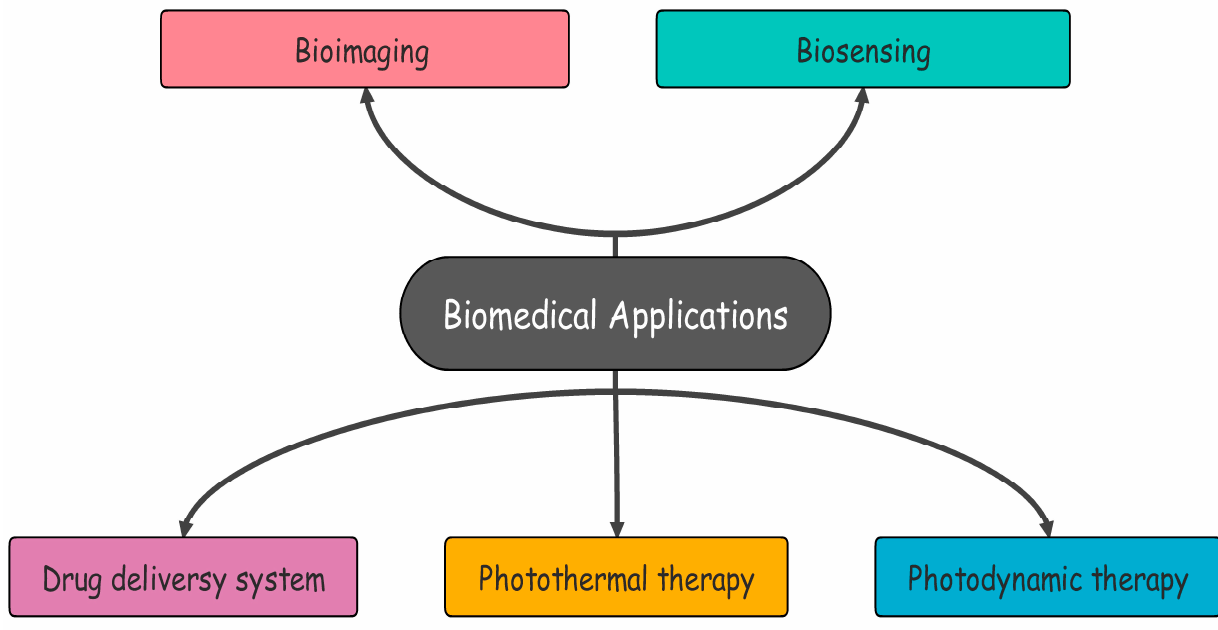
Figure 2. Biomedical applications of COFs.